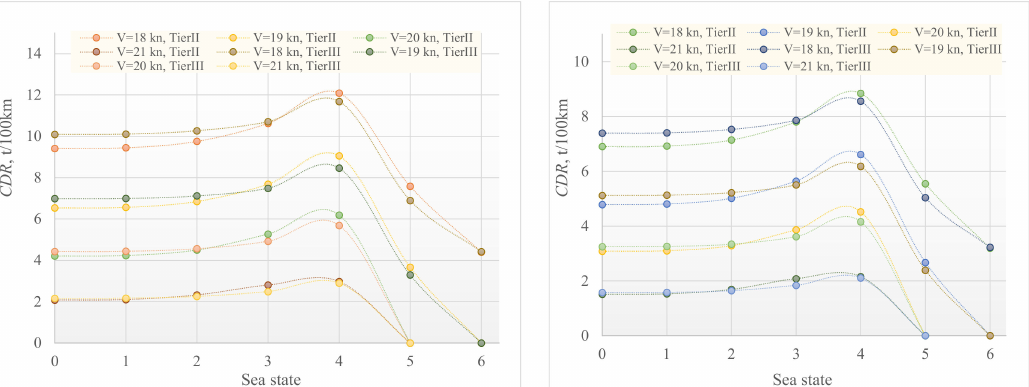
Figure 15. CO 2 emission reductions for FO ( left ) and NG ( right ) fueled engine in Tier II and Tier III mode for slow steaming speeds.